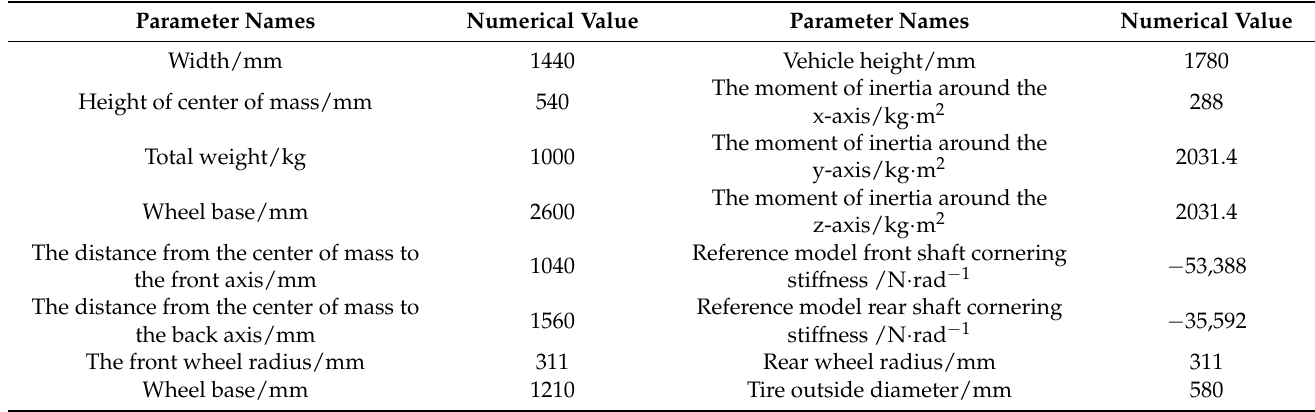
Table 1. Experimental vehicle